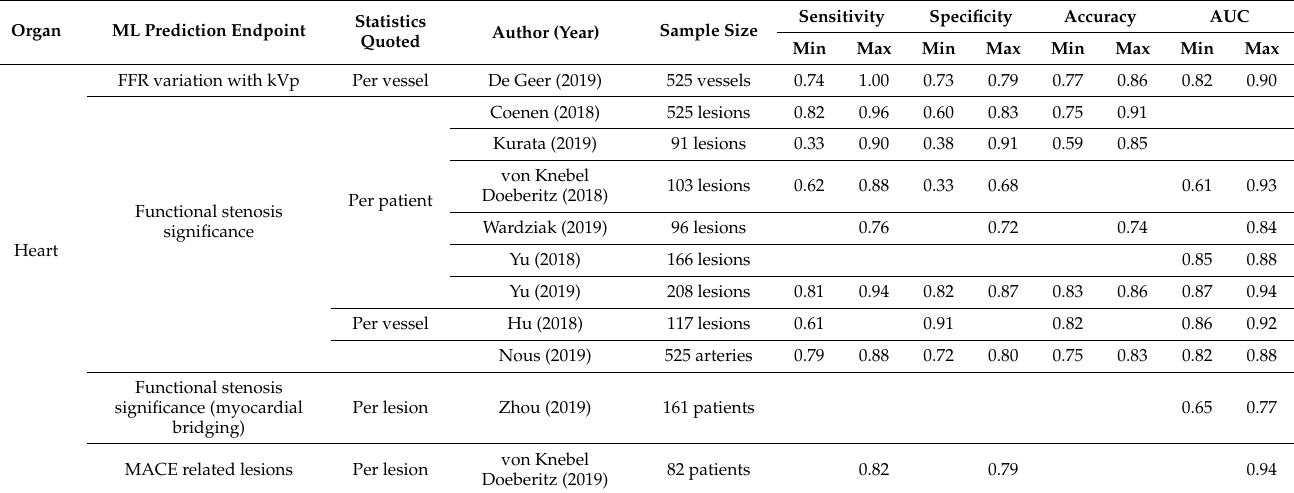
Table 3. Model performance statistics using Siemens Syngo